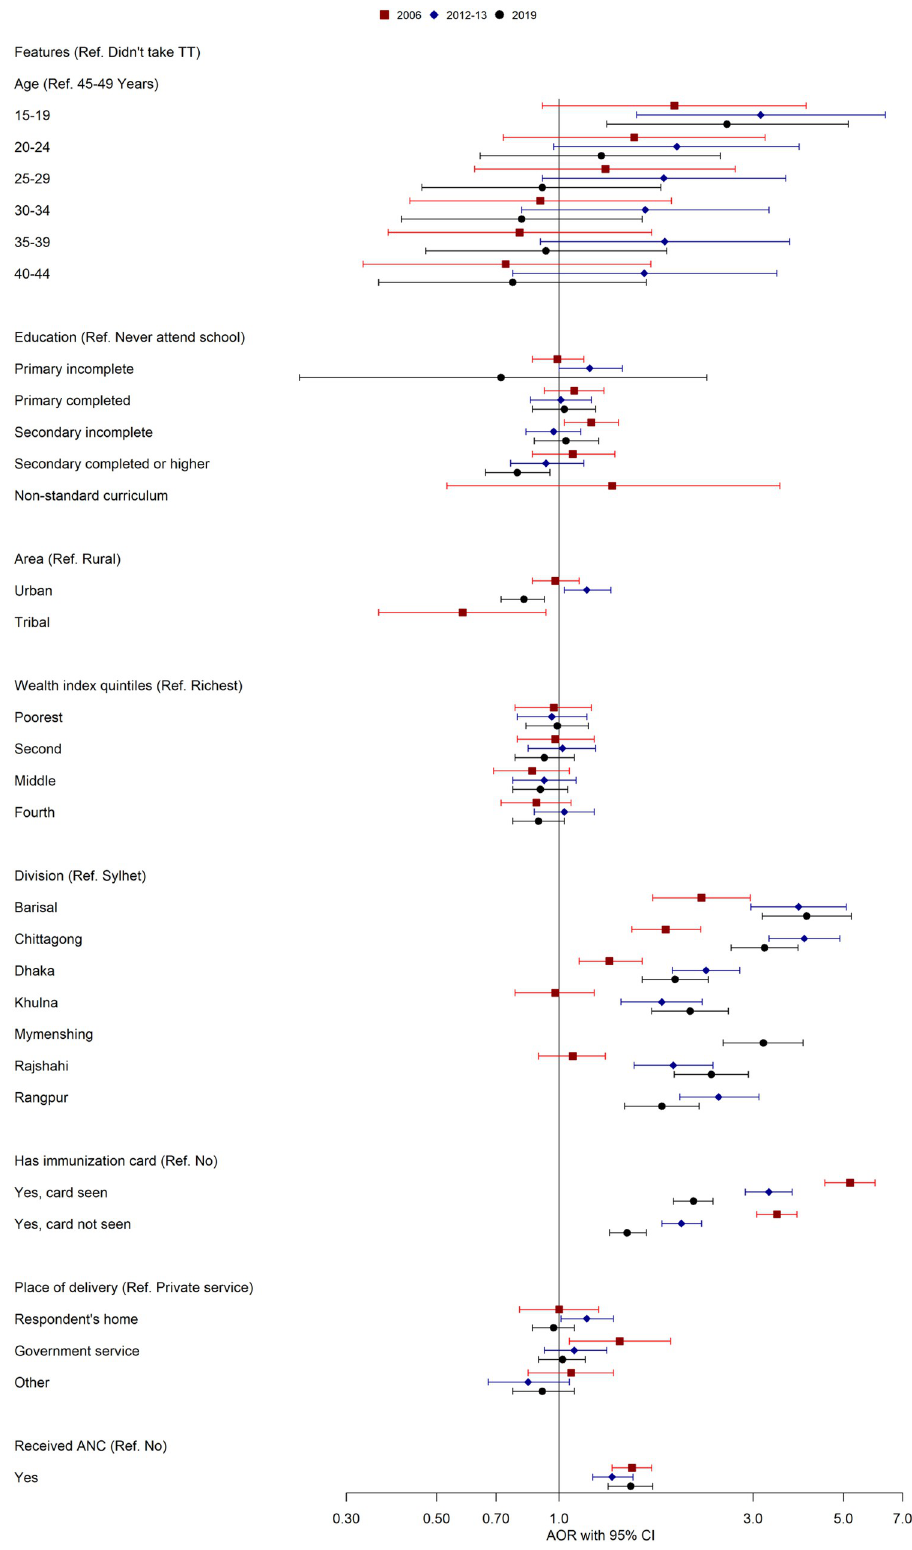
Fig 4. Determinants of taking tetanus toxoid vaccine in Bangladesh (2006–2019).